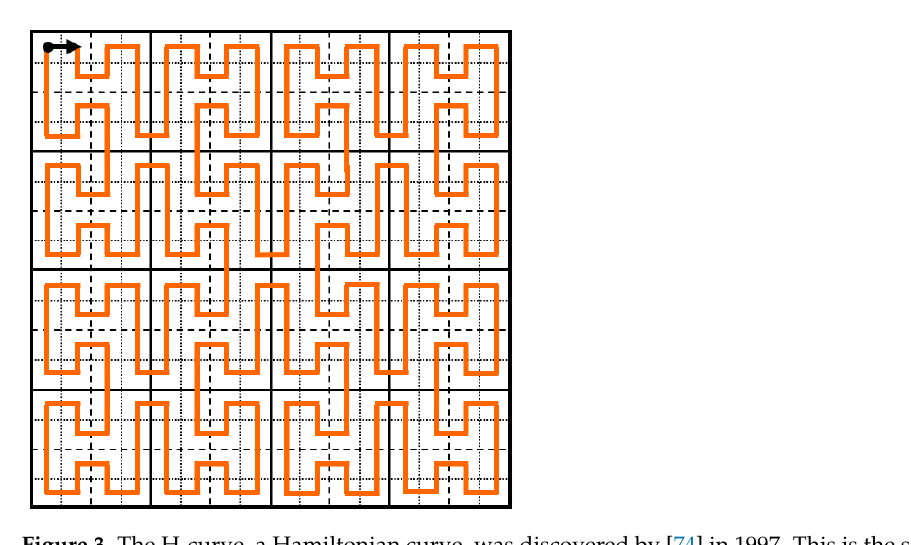
Figure 3. The H-curve, a Hamiltonian curve, was discovered by [74] in 1997. This is the sequential order for a 16 × 16